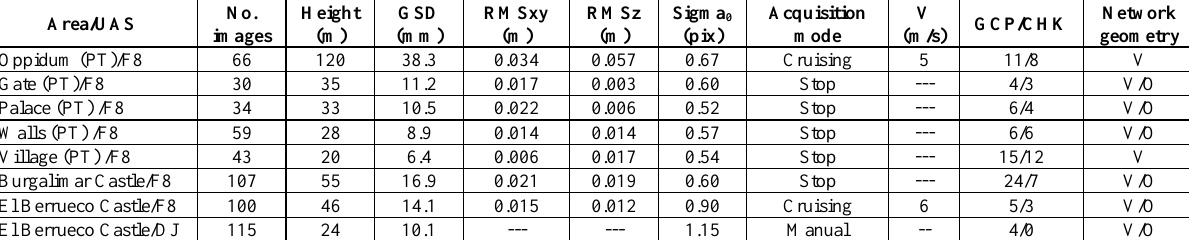
Table 1. Main flight parameters and quality of georeferencing using PhotoScan in the case studies at Puente Tablas Oppidum (PT), Burgalimar and Berrueco castles. Check points were used to derive RMS values. GCP/CHK refers to the number of GCP and check points used. The network geometry refers to only vertical image blocks or both vertical and oblique image blocks. UAS: F8 (AscTec Falcon 8); DJ (Phantom DJ 3 Advanced).